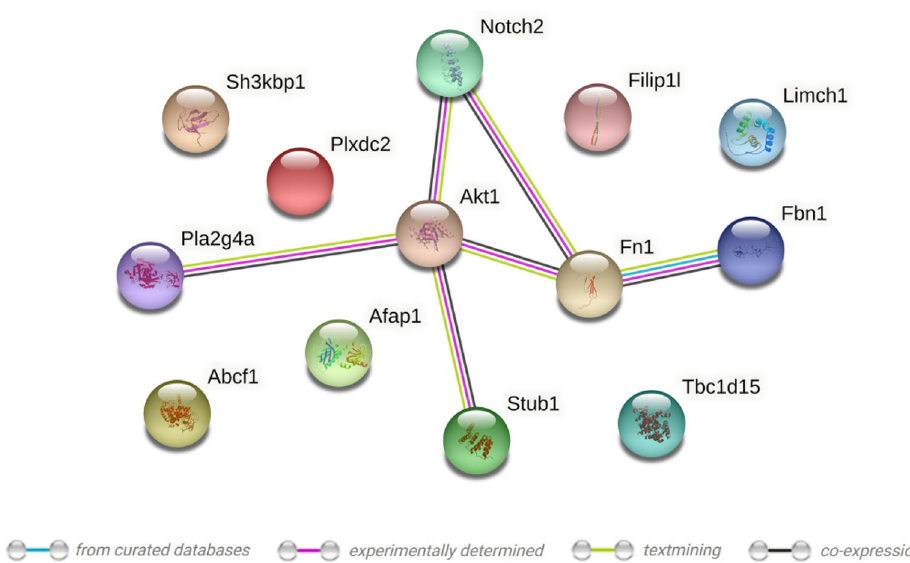
Figure 9. Potential interactions among differentially phosphorylated proteins and Akt. Colored nodes correspond to proteins and the edges represent the possibility of both functional and physical protein associations. Line color indicates the type of interaction evidence. Interaction scores: Akt1-Fn1: 0.902; Akt1- Stub1: 0.788; Akt1-Notch2: 0.644; Akt1-Pla2g4a: 0.504; Fn1-Fbn1: 0.986; Fn1-Notch2: 0.413. Cyrib from Table 1 was excluded from this analysis as no phosphorylated site was detected. The plot was generated using